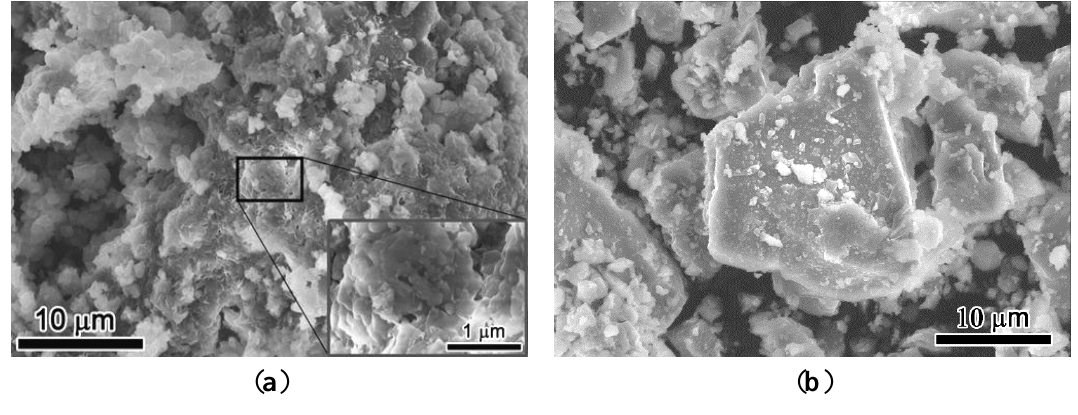
Figure 3. ( a ) SEM image of RCP; ( b ) SEM image of